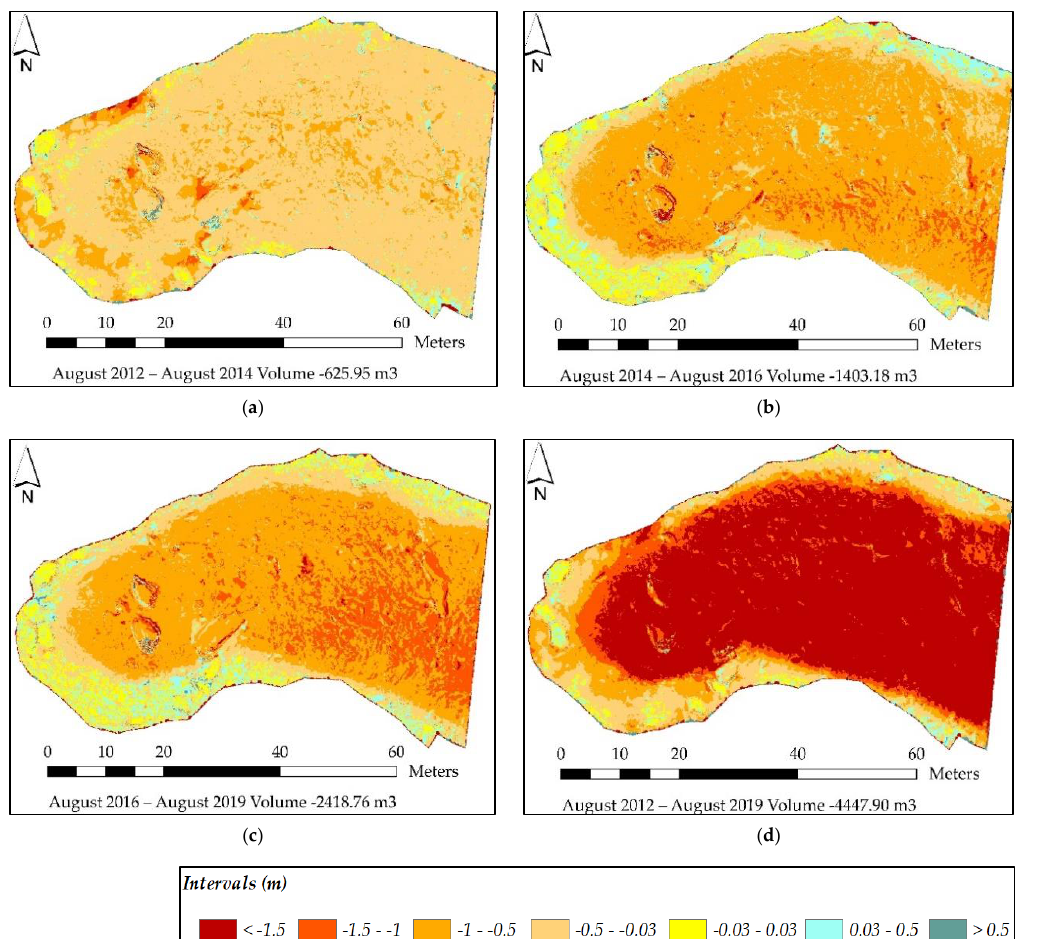
Figure 8. Comparison of digital elevation models: ( a ) Period 2012 – 2014. ( b ) Period 2014 – 2016. ( c ) Period 2016 – 2019. ( d ) Whole period (7 years) 2012 – 2019. Table 3. Calculation of the volume loss of the rock glacier using data from the TLS.